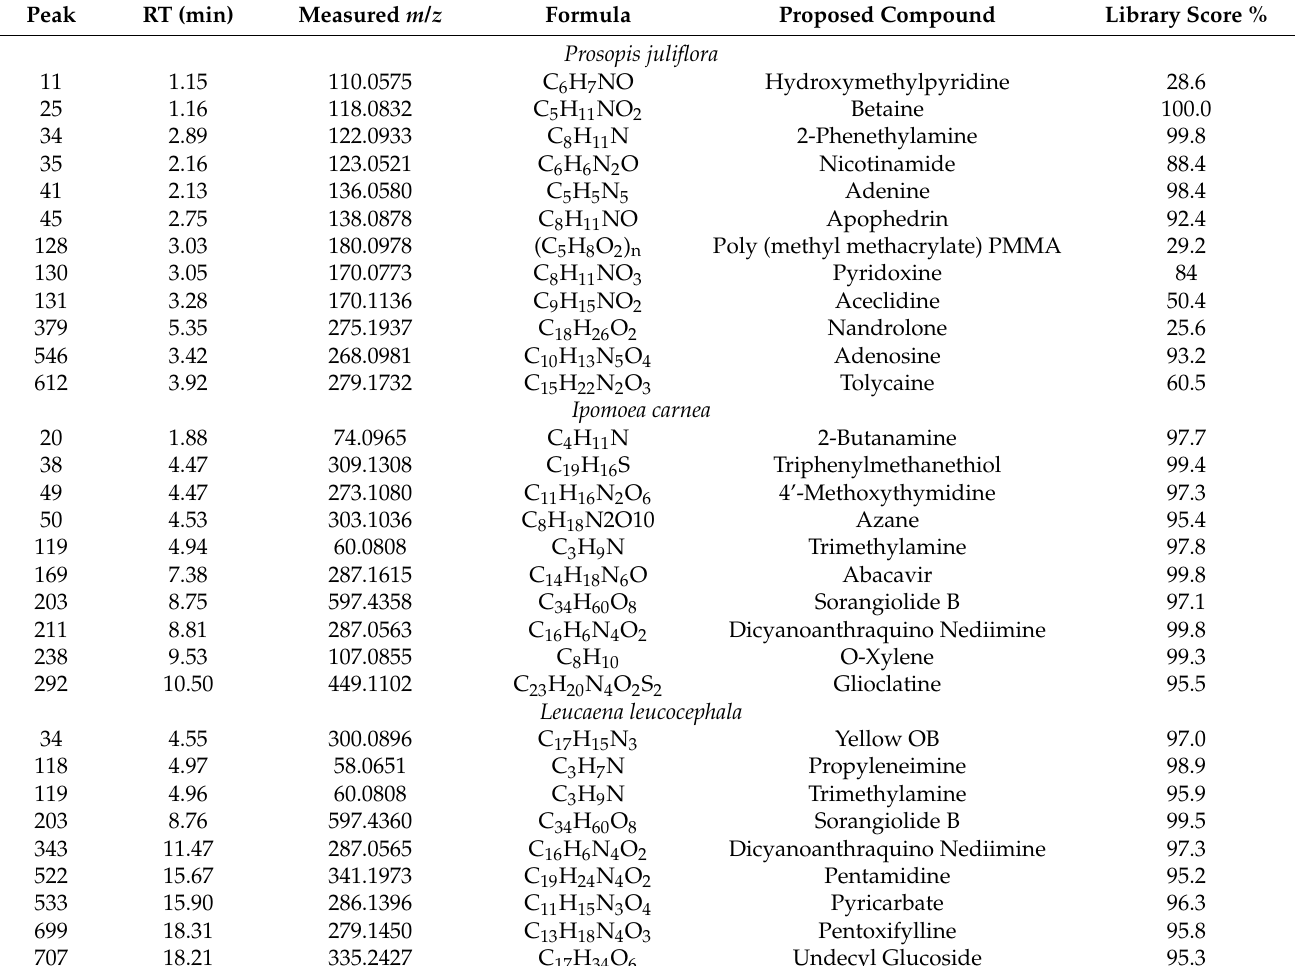
Table 5. LC-MS analysis of crude leaf extracts of Prosopis juliflora , Ipomoea carnea and Leucaena leucocephala